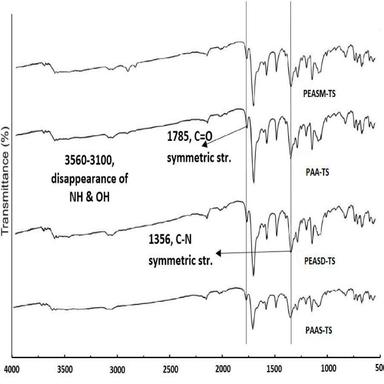
The FT-IR results of the thermosetting PI matrices.